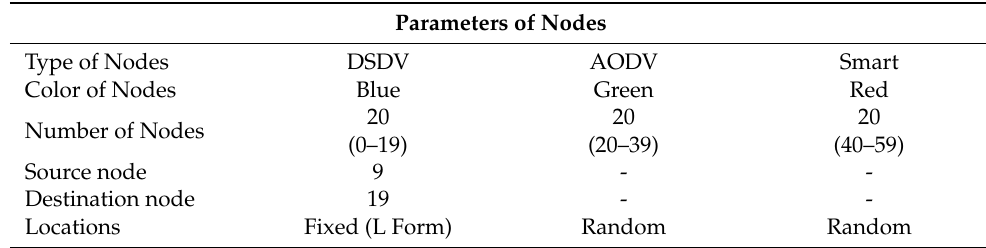
Figure 13. Case scenario 3: NS2 NetAnim Screenshot. Table 11. Case 3: Parameters for classes of